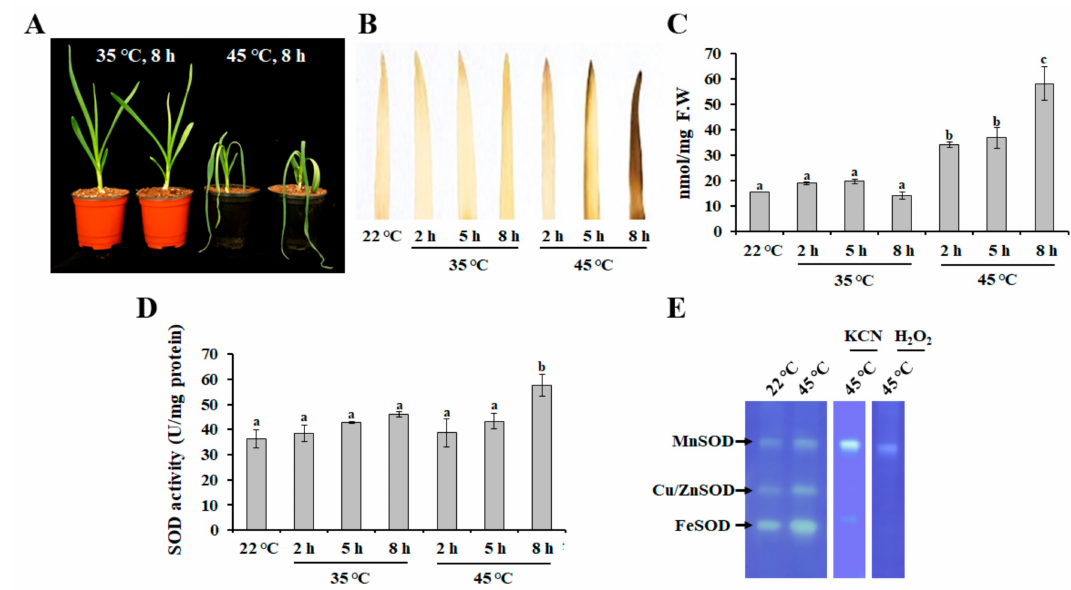
Figure 1. Physiological response of garlic plants under heat stress. Changes in phenotypes ( A ), H 2 O 2 level ( B ), malondi- aldehyde level ( C ), total SOD activity level ( D ), and the activity pattern of SOD isozymes ( E ) were determined. In-gel SOD activity assay was performed using total protein obtained from heat-treated samples (45 ◦ C for 8 h). The bars represent the mean ± SE across five independent experiments. Different letters indicate statistically significant differences ( p <